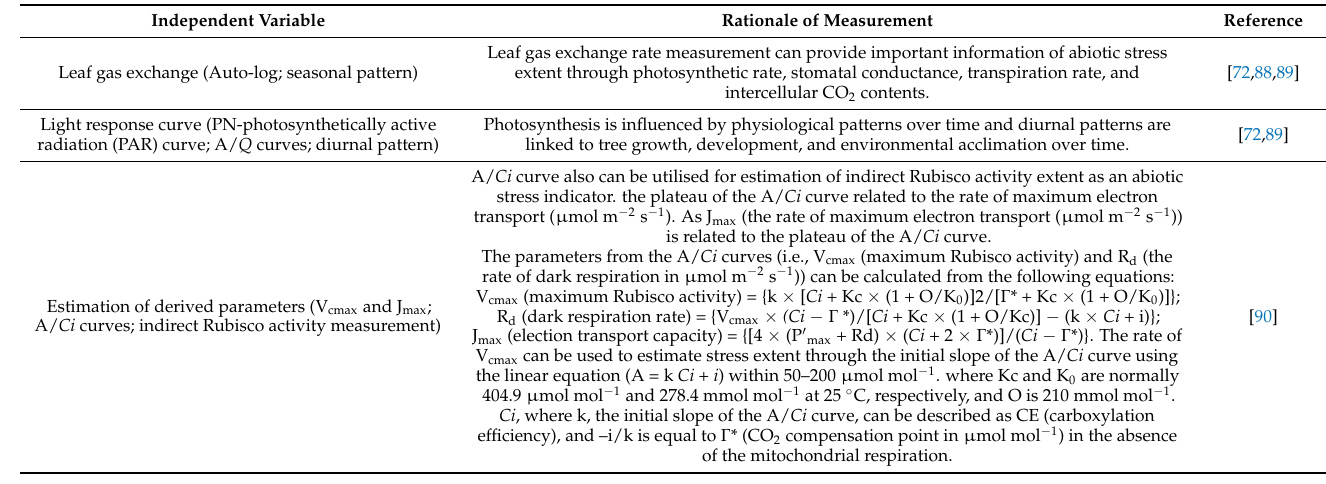
Table 1. General parameters of measurement for effects of abiotic stressors on tree